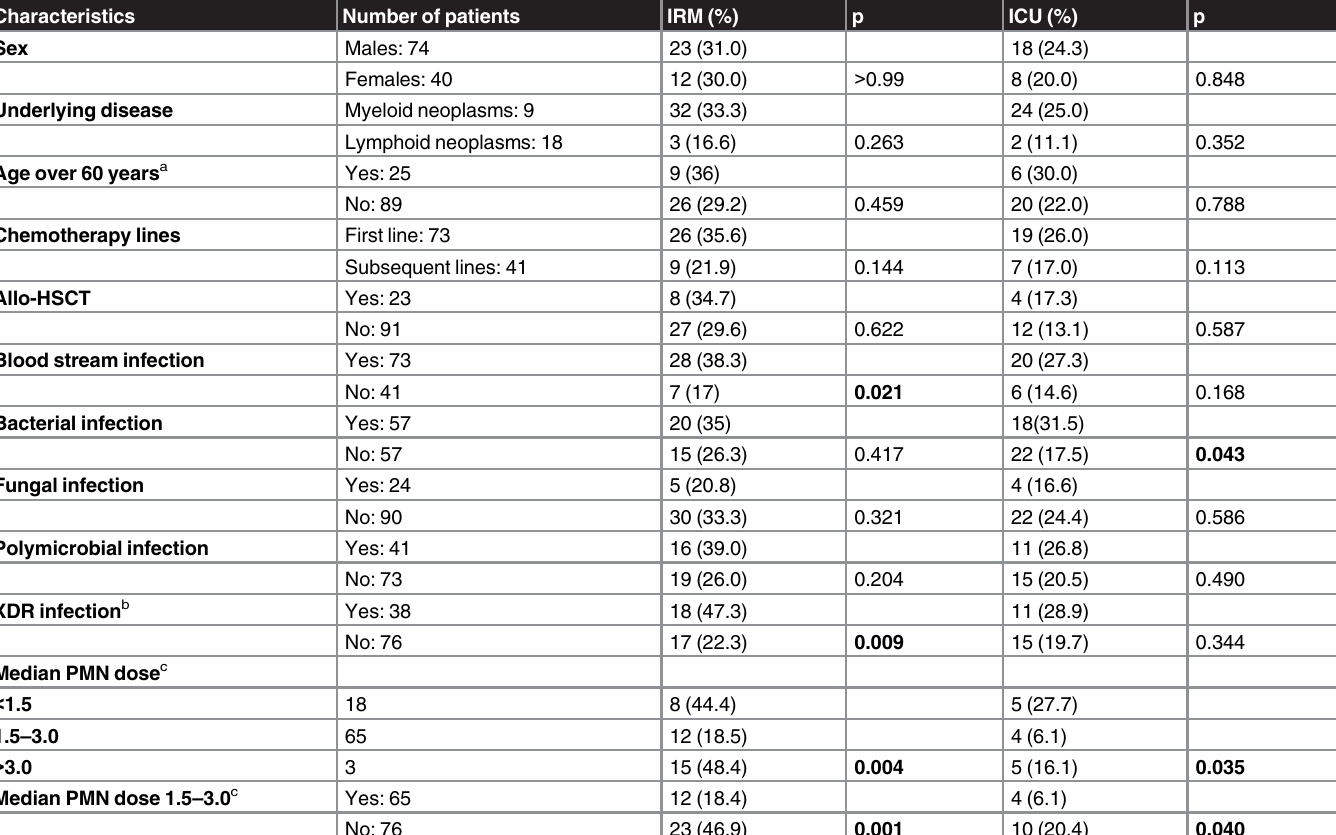
Table 3. Effect of clinical, microbiological and transfusion findings on requirement of ICU admission and infection-related mortality (univariate analysis). Characteristics